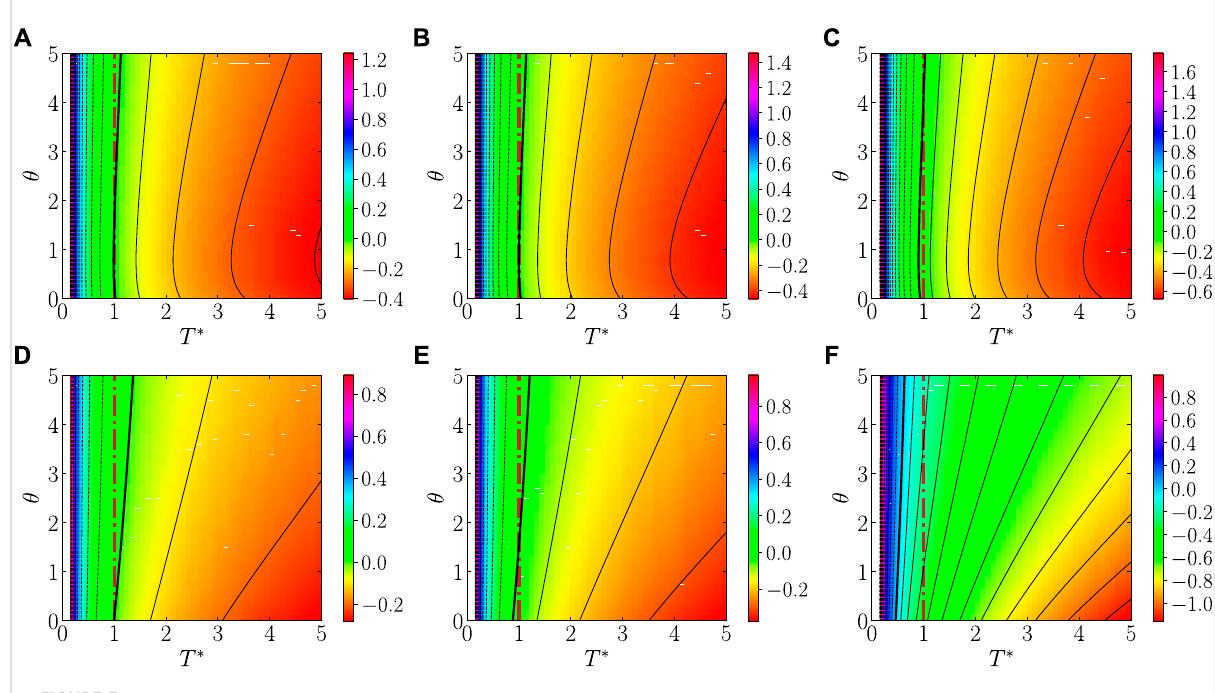
FIGURE 3 Densityplotsof Φ ( T *, θ )for α =0.9and (A) β =0, ε =0; (B) β =0, ε =0.5; (C) β =0, ε =1; (D) β = − 0.7, ε =0; (E) β = − 0.7, ε =0.5;and (F) β = − 0.7, ε =1. Thecontourlines(solid for Φ < 0,dashedfor Φ > 0) areseparatedbyanamount ΔΦ =0.1.Thethicksolidline isthelocus Φ ( T *, θ )=0.Itinterceptsthe (brown dash-dotted) vertical line T * = 1 at θ = θ st